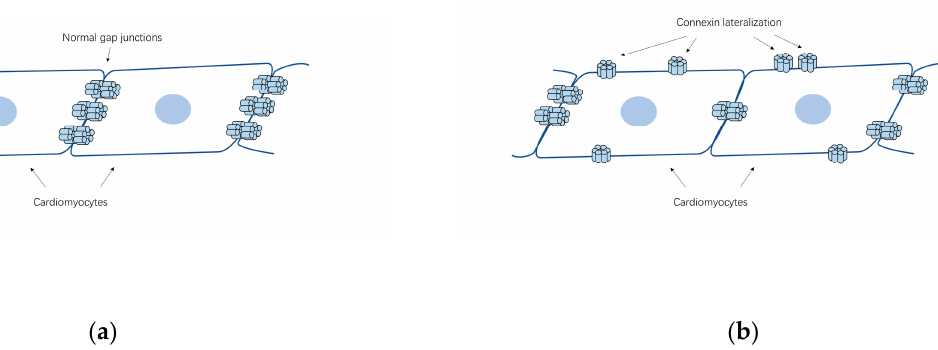
Figure 2. The schematic diagrams of the lateralization of cardiac connexins in AF. ( a ) Schema of the cell-to-cell connections by gap junctions in normal heart; ( b ) The lateralization of connexins from cell poles to lateral margins, which can be related to AF.